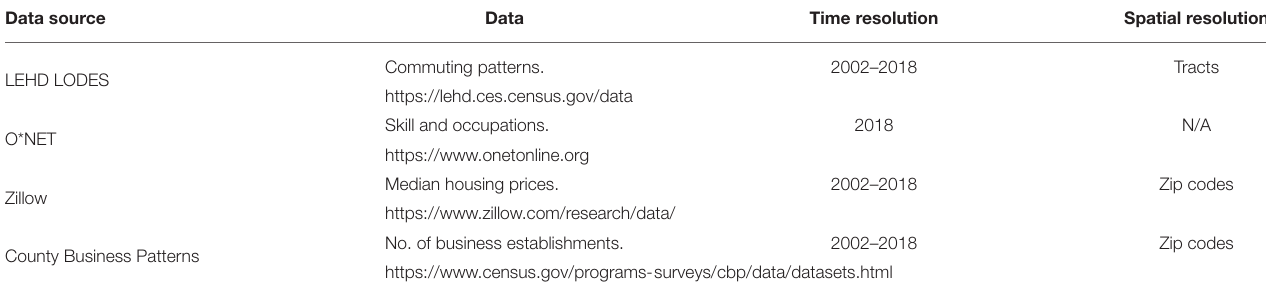
TABLE 1 | Data overview